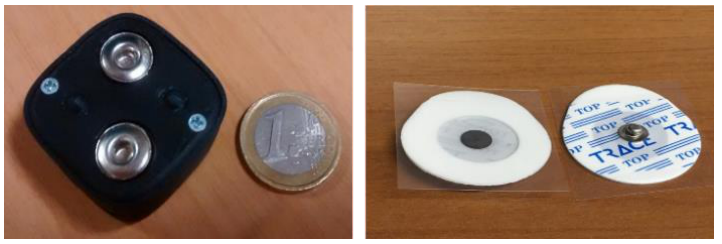
Figure 2. Back-side of Bio2Bit Move and the electrodes.